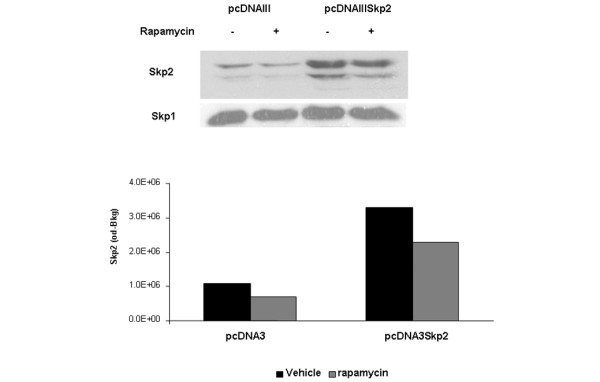
T47D cells were transiently transfected with a Skp2 insert or an empty plasmid (vehicle) and treated with rapamycin (20 nM) for 48 h. Levels of Skp2 protein levels were determined by western blot analysis. Optic Density (od) of the Skp2 band as measured by chemiluminesence – blot background (Bkg).